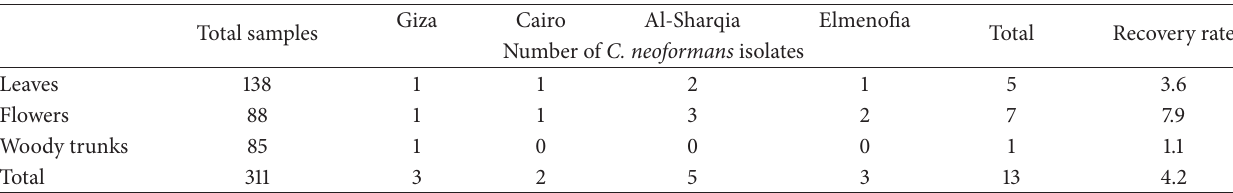
Table 3: Recovery rate and distribution of C. neoformans in tested Eucalyptus trees sampled in the Delta region.